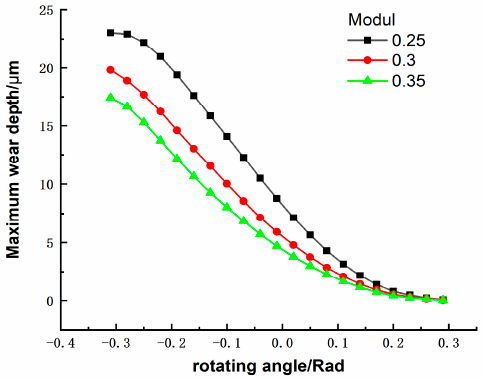
Figure 17. Effect of modulus on maximum wear depth.